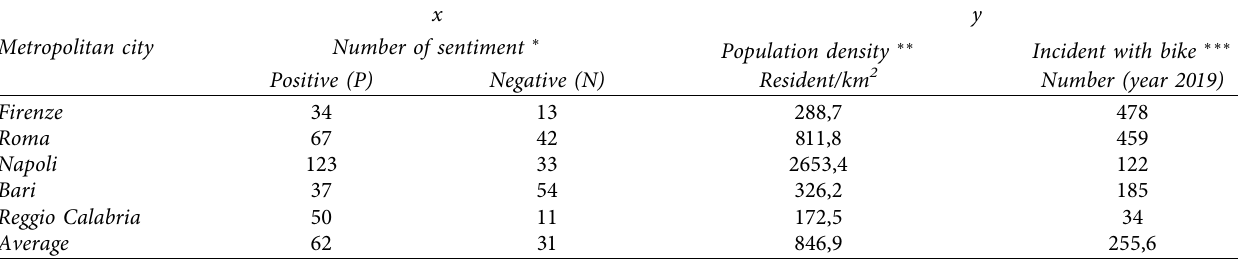
Table 3: Number of positive and negative sentiment for the Italian metropolitan cities